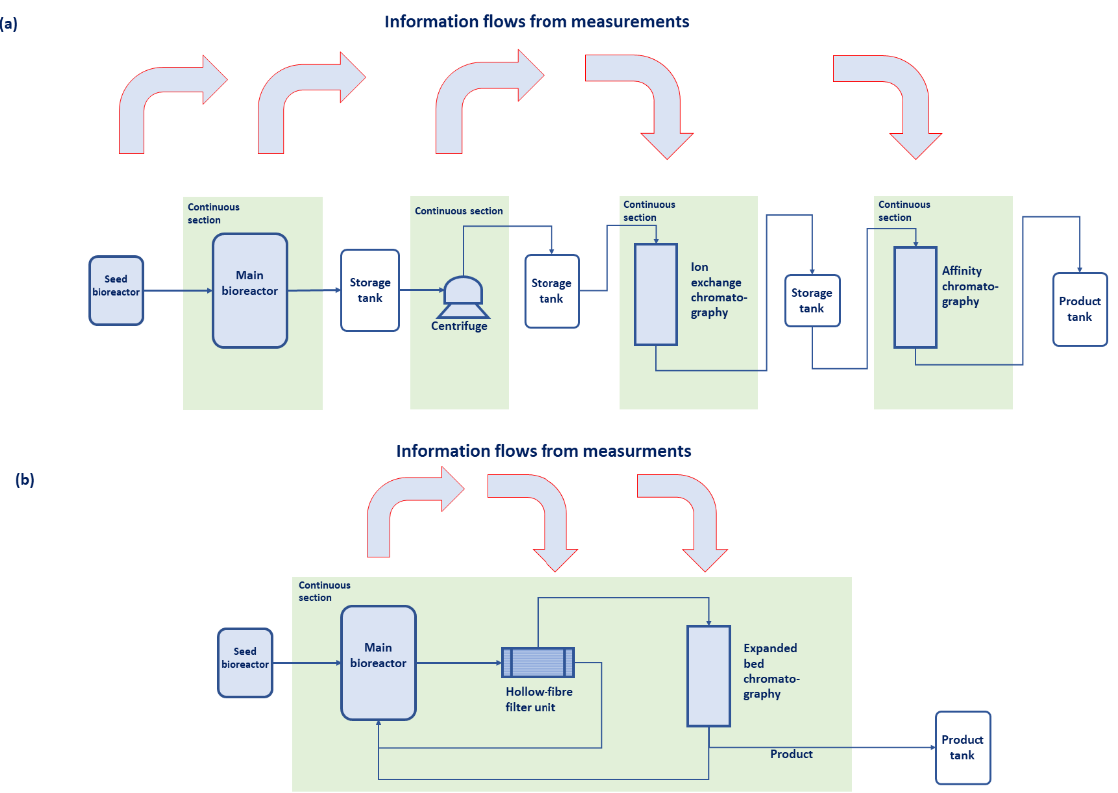
Figure 1. Bioprocess integration requires measurement technology that allows continuity and just-in-time information flow. ( a ) A conventional bioprocess with separate unit operations, ( b ) an end-to-end bioprocess with integrated and recycled flows between units. Depicted unit operations are examples.